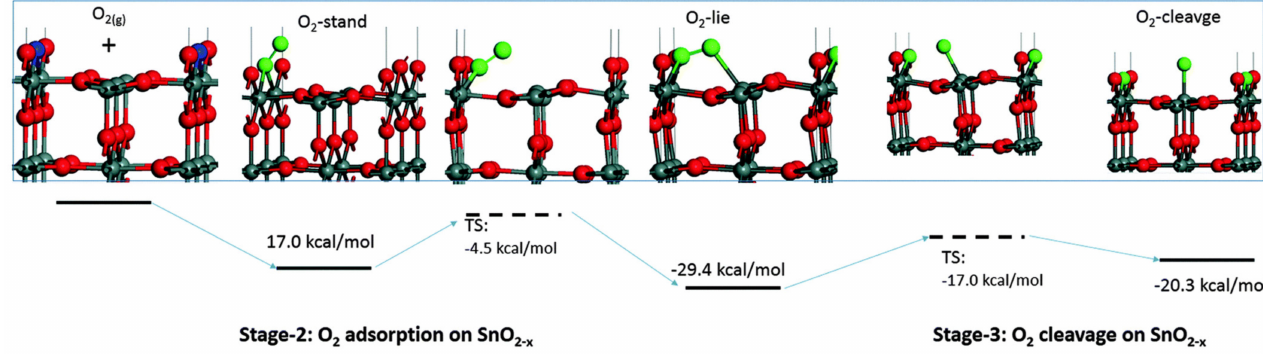
Figure 2. Adsorption of O 2 onto a (110) surface of SnO 2 with an isolated vacancy. From left: a (110) surface with a single (periodic) bridging vacancy (blue), “O-stand” superoxide molecular adsorbate in the end-on configuration, “O-lie” peroxide molecular adsorbate in the side-on configuration and “O-cleavage” monoatomic O – adsorbate adjacent to a healed vacancy—now O br . Reproduced with permission from Reference